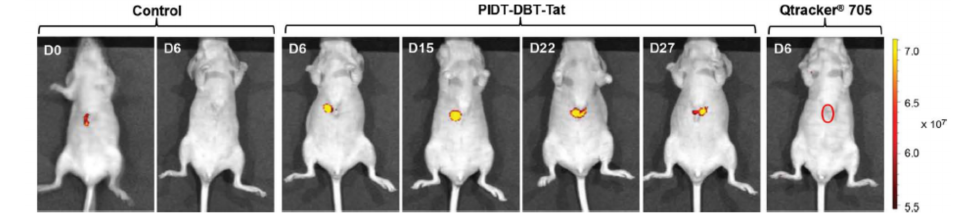
Figure 12. Representative in vivo fluorescence images of a mouse transplanted with 4 × 10 6 of HepG2 cells labeled by CPNP 16 and Qtracker 705. Control images were obtained from a nude mouse that underwent the same surgical operation without injection of labeled HepG2 cells. The images were taken on designated days post cell injection ( λ ex = 640 nm, 720/20 nm filter). Reproduced with permission [46]. Copyright: 2015,